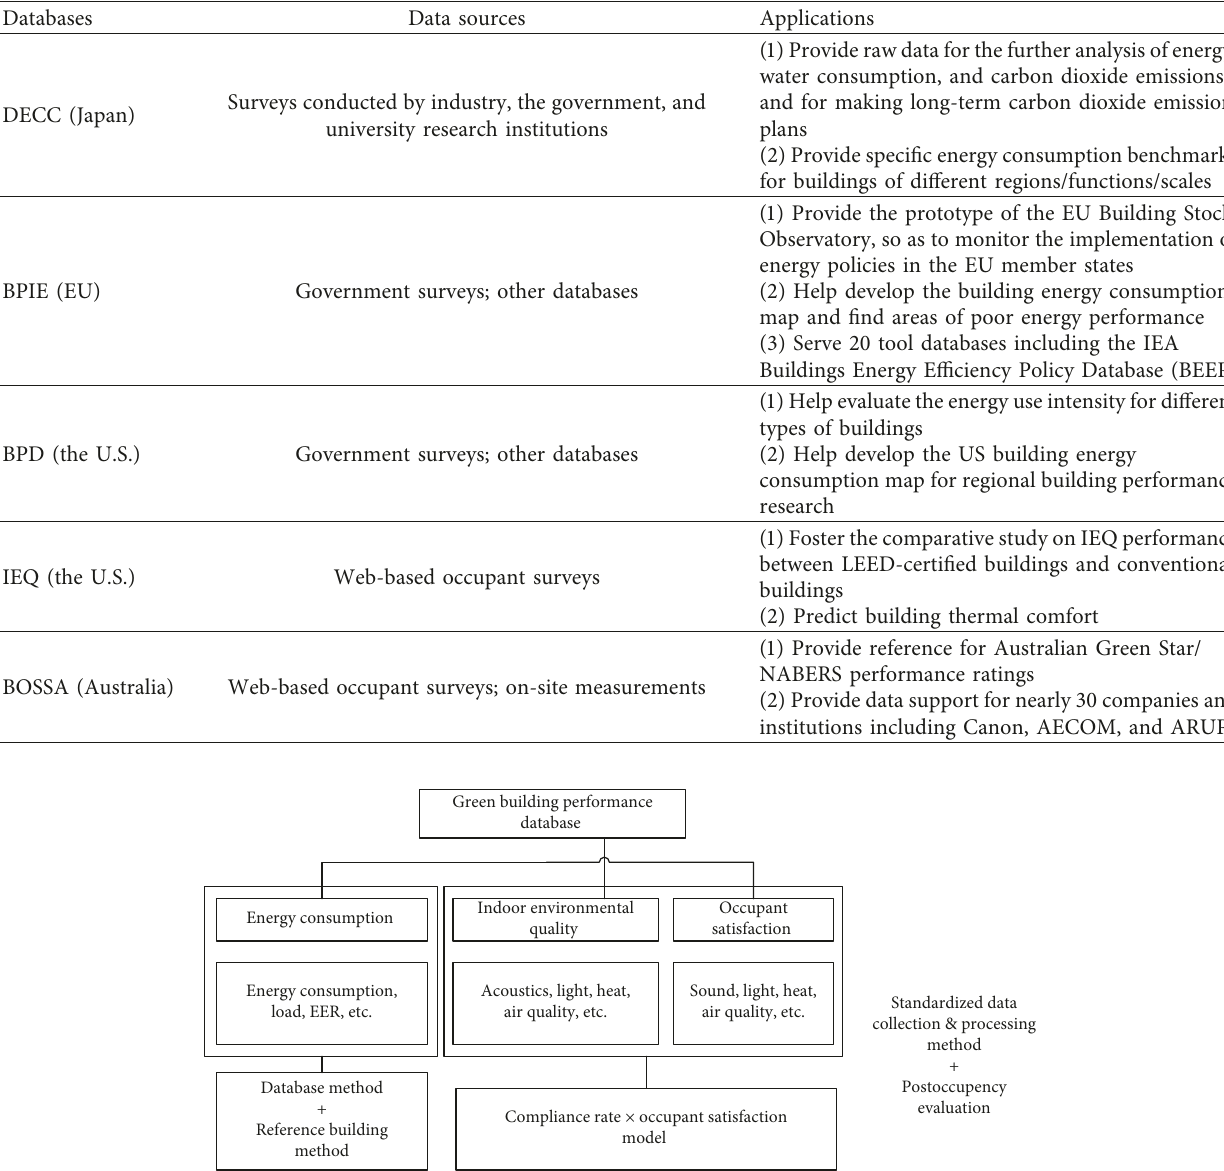
Table 2: Data processing methods used in representative building performance databases.